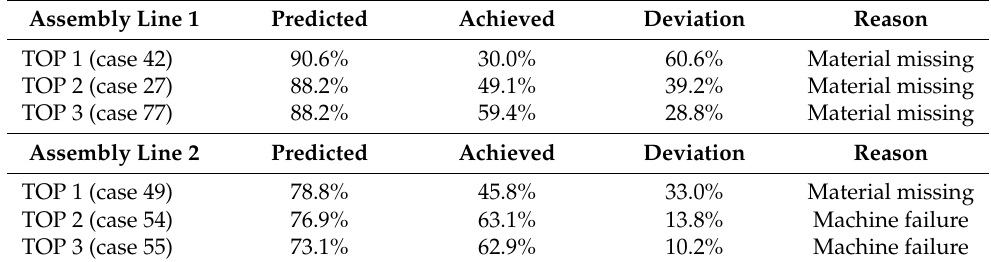
Figure 5. Deviation from the estimation for assembly line 2. Table 5. TOP 3